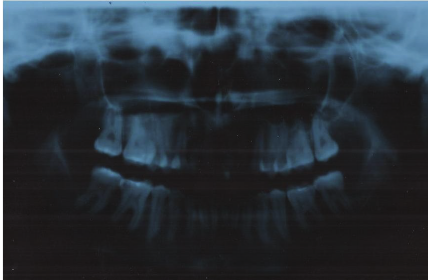
Figure 4: X-ray for postoperative